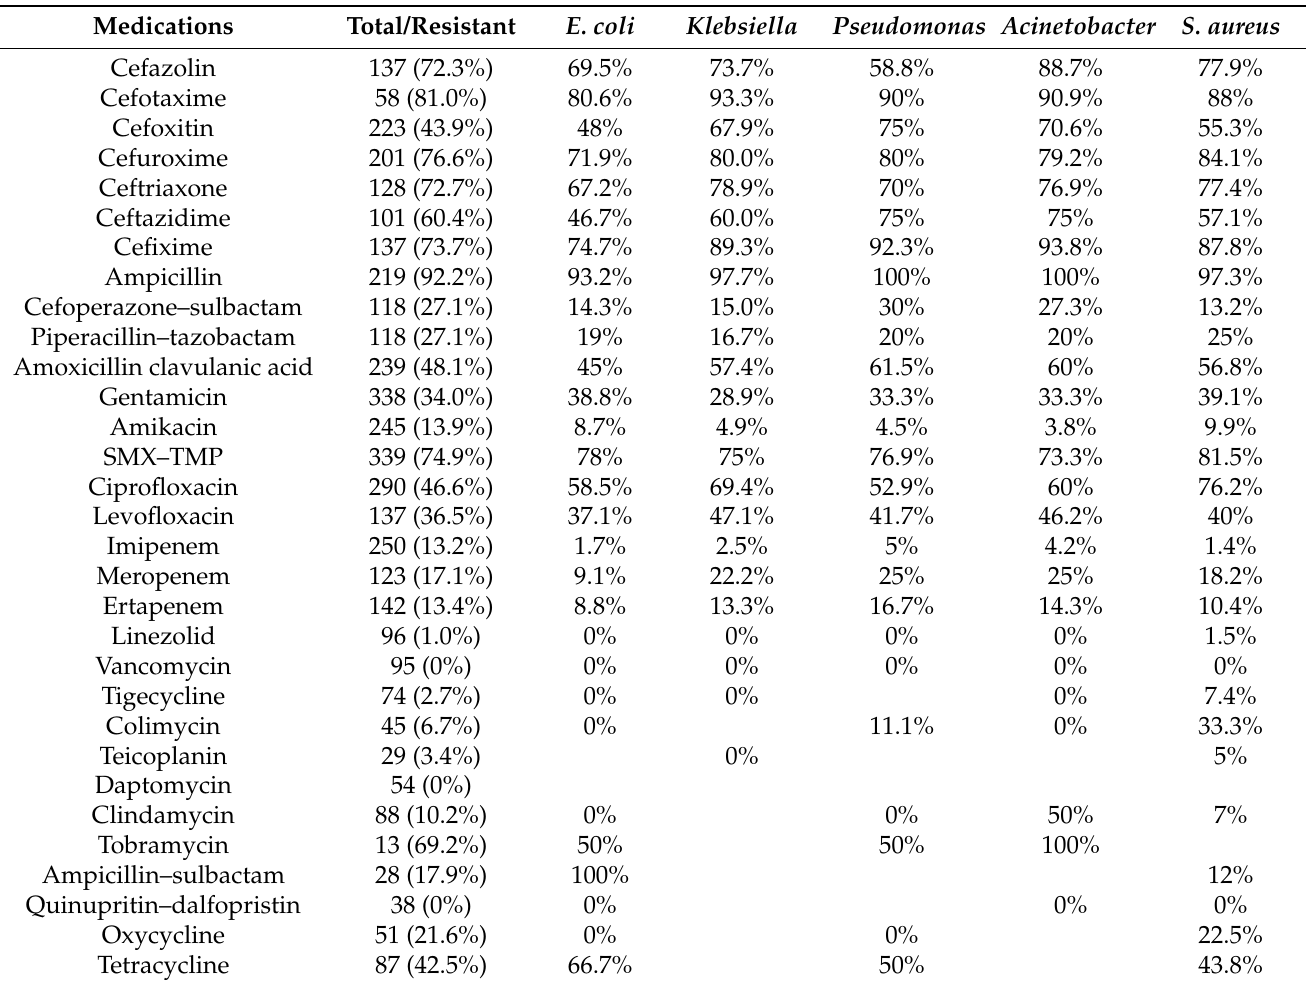
Table 3. Distribution of antibiotic resistance and antimicrobial profiles of specific